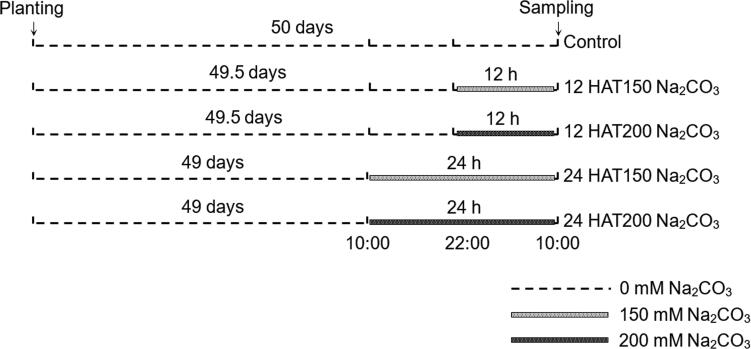
Cluster analysis of the homologous gene expression patterns of alkaligrass chloroplast phosphoproteins under Na2CO3 treatment for 24 h Heat map of the 28 homologous genes from Puccinellia tenuiflora leaves under Na2CO3 treatments (0 mM, 150 mM Na2CO3 for 24h (24 HAT150), and 24 HAT200), three main clusters (I–III) are shown in the figure. The scale bar indicates log2 transformed relative expression levels of genes. The up-regulated and down-regulated genes are presented in red and green, respectively. Homologous gene names are listed on the right side.